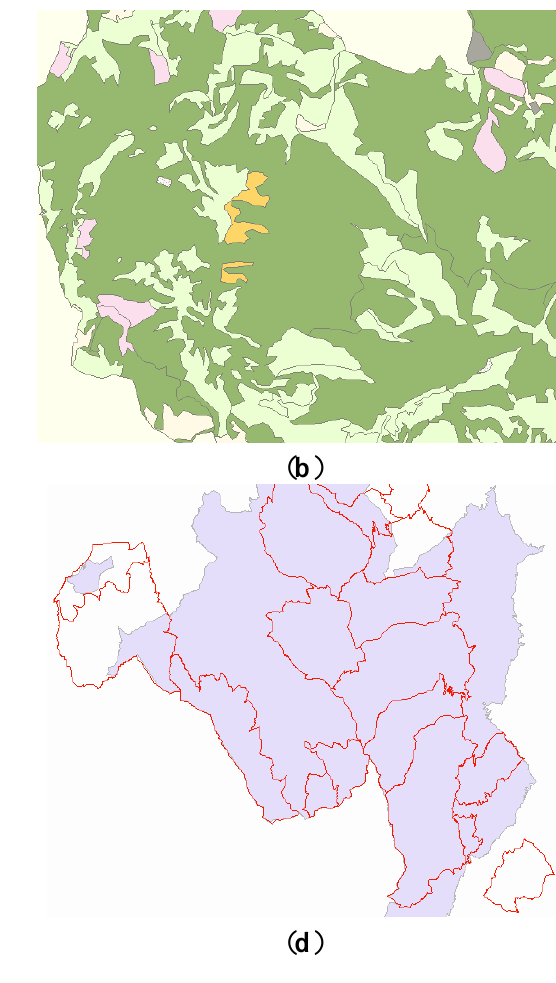
Figure 4. Four different outputs of the SIT-REM web GIS at scale 1:50,000. In particular, among other features and data analysis, users can view: ( a ) fauna surveys (green squares) and their geographical displacements; ( b ) physiognomic map (dark green areas are wood regions); ( c ) phytosociological map of actual vegetation (light textured green areas represent Centaureo Bracteatae-Brachypodietum); ( d ) administrative limits (pink area) of protected